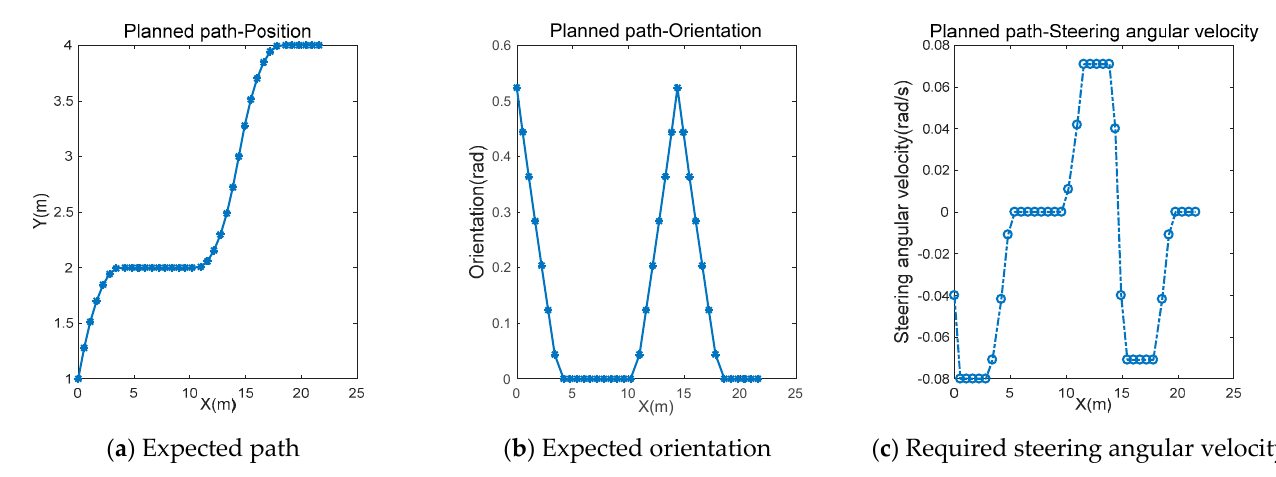
Figure 11. The pre-designed transition path for the yawed roadheader.